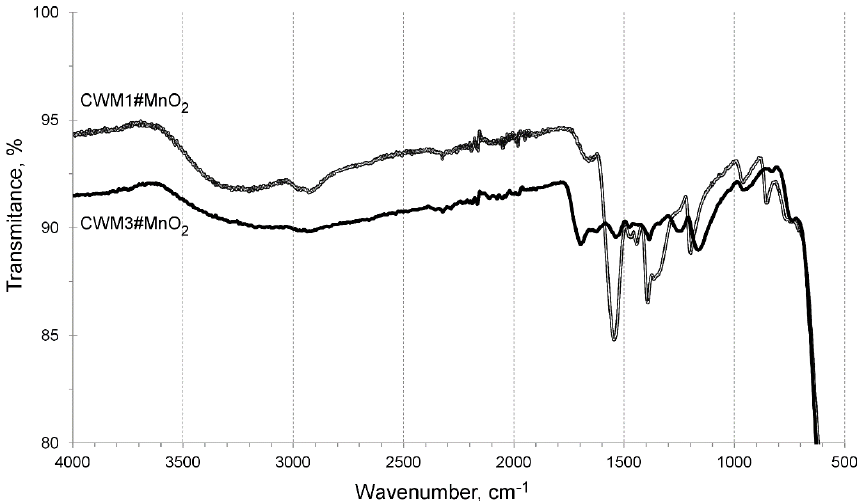
Figure 3. FTIR spectra of CWM#MnO 2 in medium infrared range.